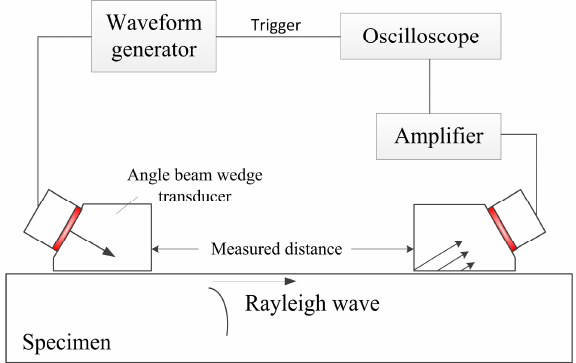
Figure 11. Sketch of experiment setup.